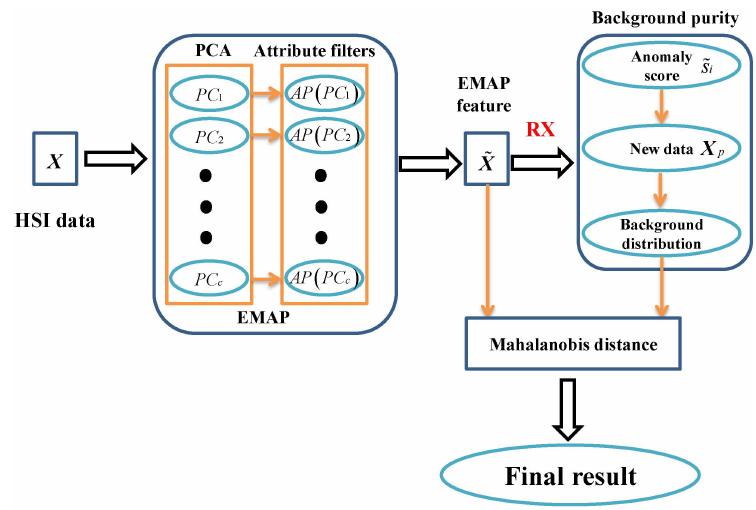
Figure 2. Description of RRXEMAP